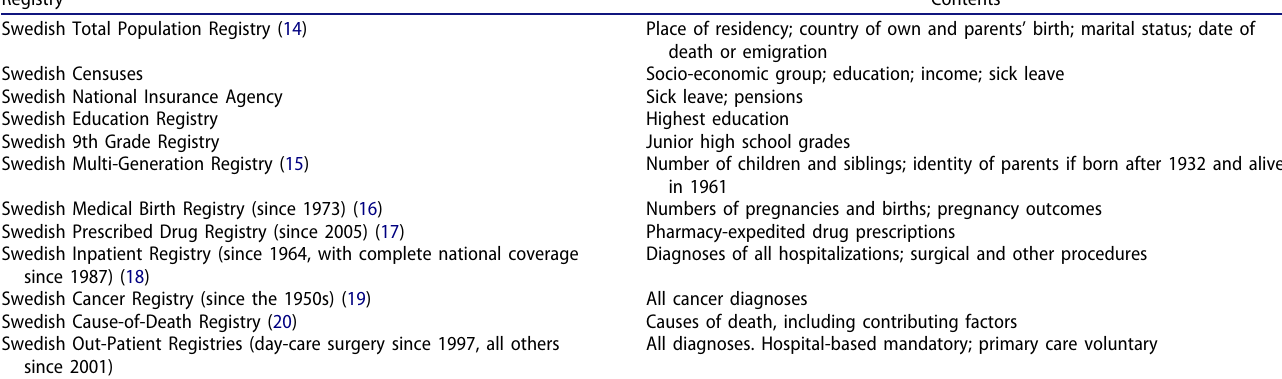
Table 1. Examples of Swedish official registries.